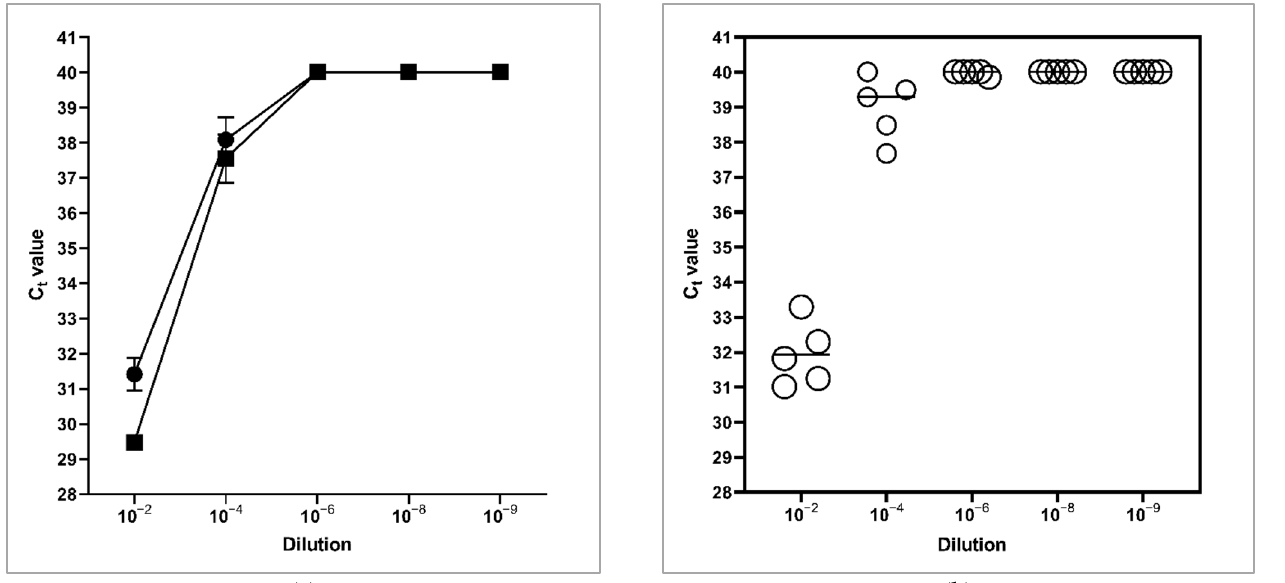
Figure 2. C t values obtained for serial dilutions of Mycobacterium avium subspecies paratuberculosis on udder skin by sampling with cotton swabs after DNA extraction using the QIAamp DNA Mini Kit (Qiagen, Hilden, Germany) and the ADIAVET PARATB REAL TIME PCR kit (Adiagene, Bio-X Diagnostics S.A., Rochefort, Belgium). ( a ) Comparison of dry ( (cid:108) ) and moistened swabs ( (cid:4) ) expressed as means ± SD; ( b ) Comparison of dry swabs from trial 1 and 2. Each dot represents an individual sample. Mean C t values of the dilutions are denoted by horizontal lines.